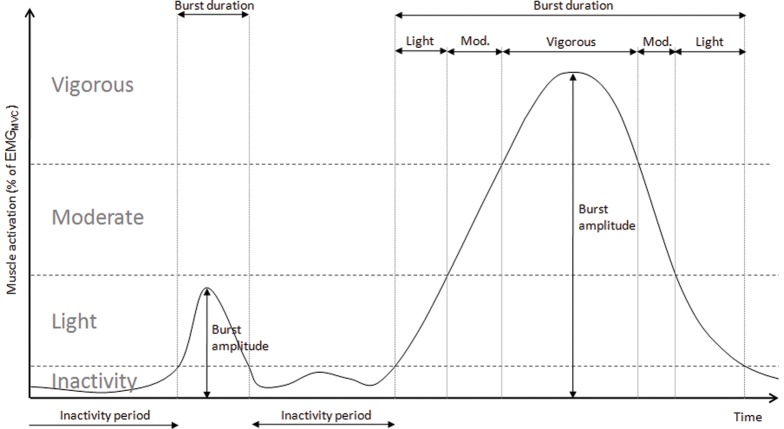
Analysis of burst characteristics and muscle activities.Schematic drawing depicting analysis of burst amplitude, duration, inactivity periods and differentiation to light, moderate and vigorous muscle activities. The thresholds for inactivity, light, moderate and vigorous activities were determined individually (see text).